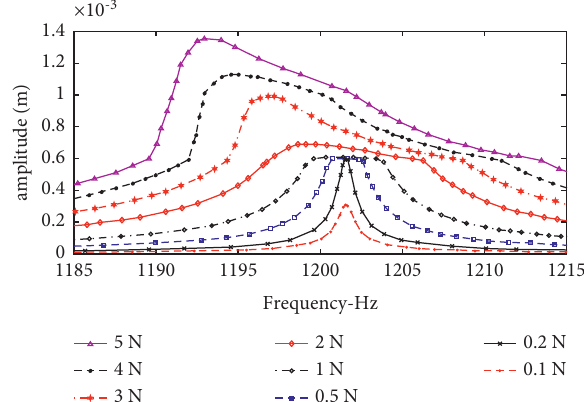
Figure 3: Frequency response function of reference [40]. Continuous lines are for reference [40] and circle point is regenerated of this paper for different excitation